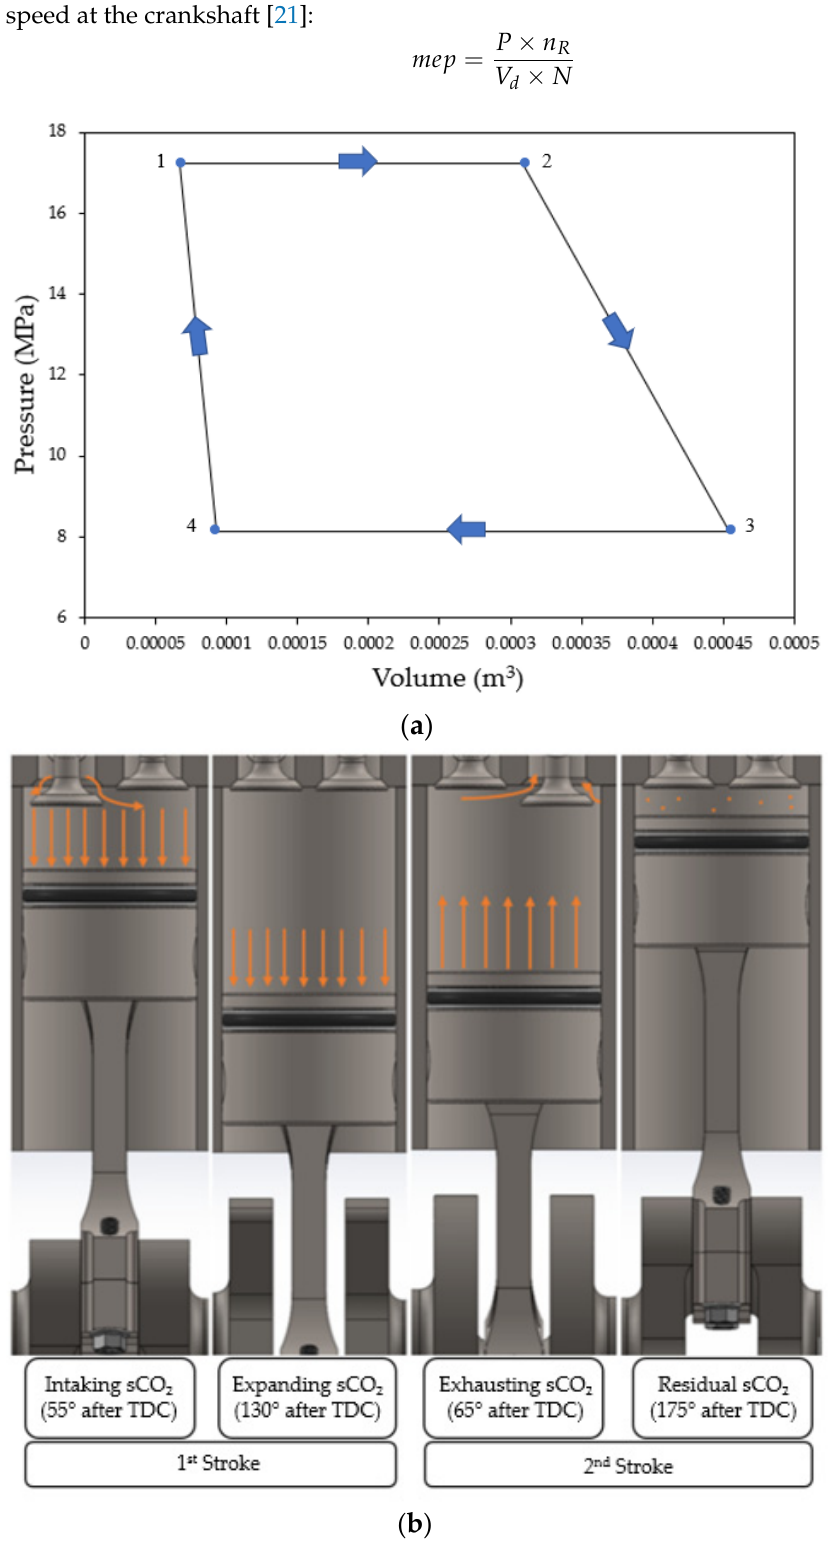
Figure 8. ProcessofsCO 2 insidethecylinder: ( a )pressurevs. volumediagramand( b Figure 8. Process of sCO 2 inside the cylinder: ( a ) pressure vs. volume diagram and ( b ) visual repre- sentation.